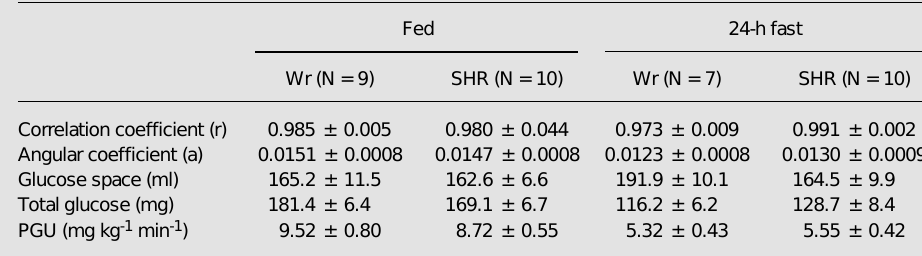
Table 2 - Peripheral glucose utilization (PGU) in SHR and Wistar rats (Wr) in the fed state and after a 24-h fast. Data are reported as means ±